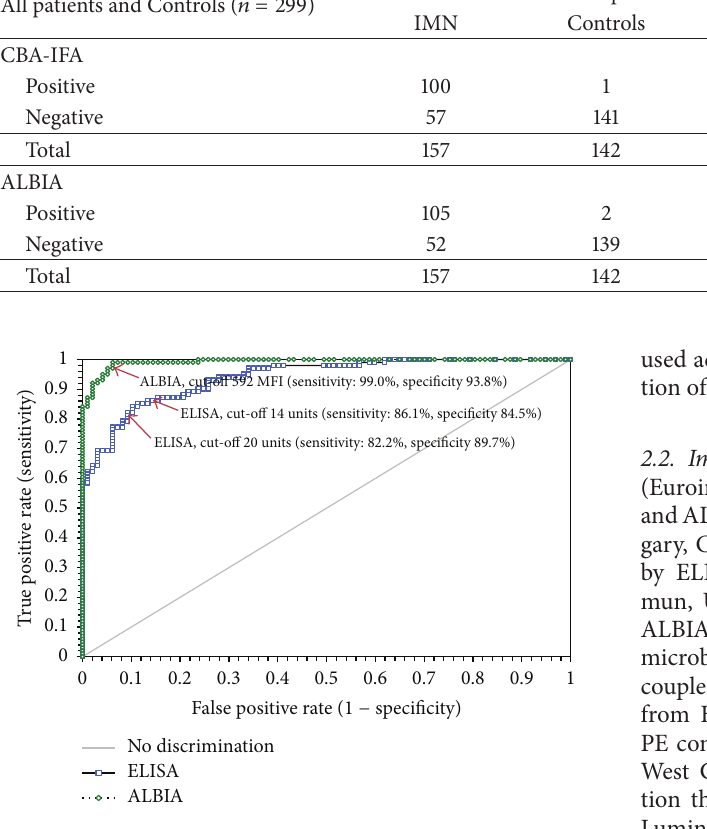
Table 2: Clinical sensitivity and specificity for CBA-IFA and ALBIA. All patients and Controls ( 𝑛 = 299 )